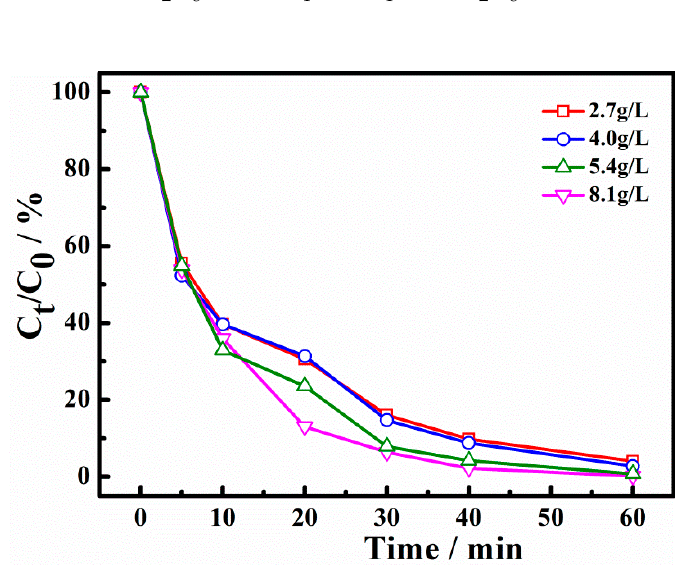
Figure 6. E ff ect of persulfate (PS) dosage on degradation of Figure 6. Effect of persulfate (PS) dosage on degradation of X-3B. Figure 6. Effect of persulfate (PS) dosage on degradation of X-3B.